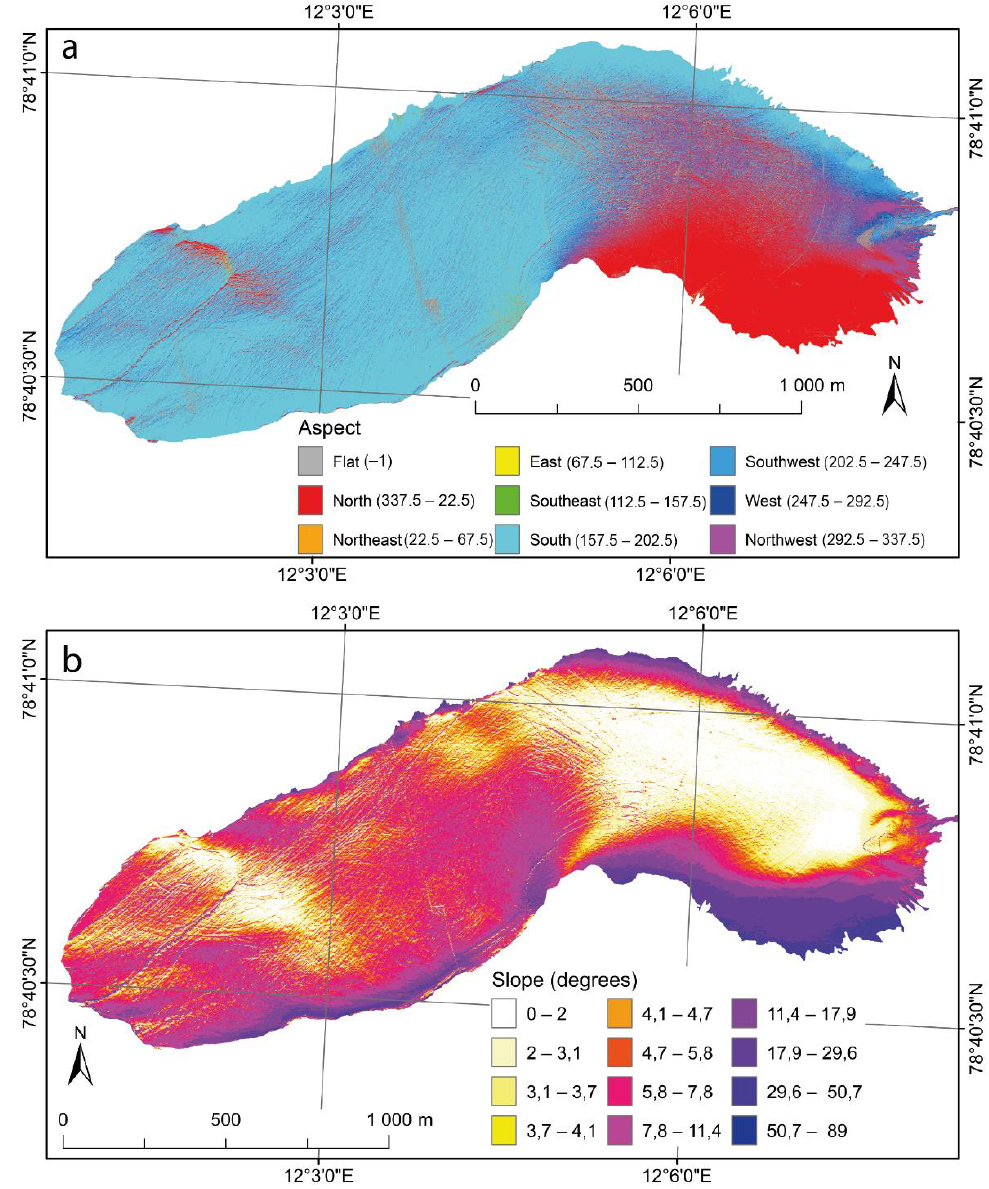
Figure 5. ( a ) Aspect and ( b ) slope of Waldemarbreen generated from UAV